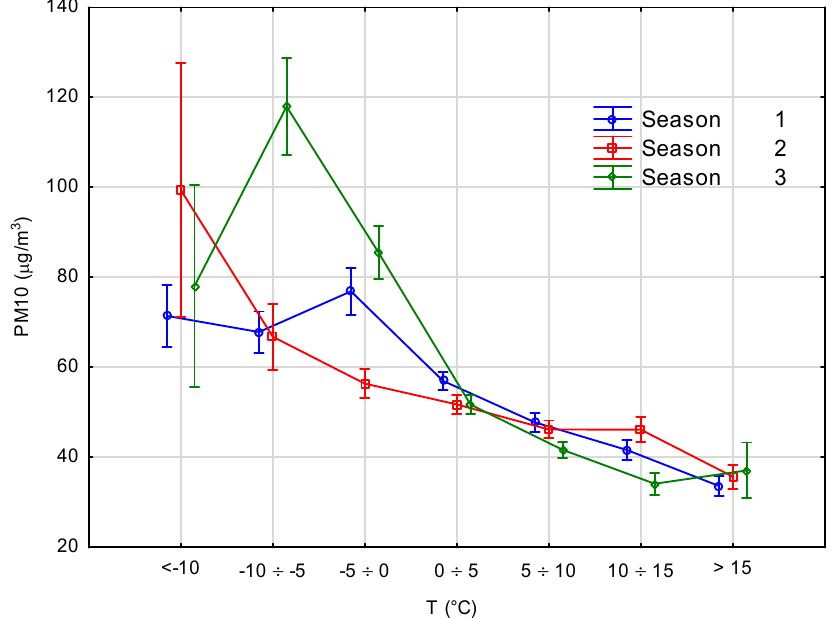
Figure 6. Relation between PM 10 concentration and temperature for the analyzed heating seasons.